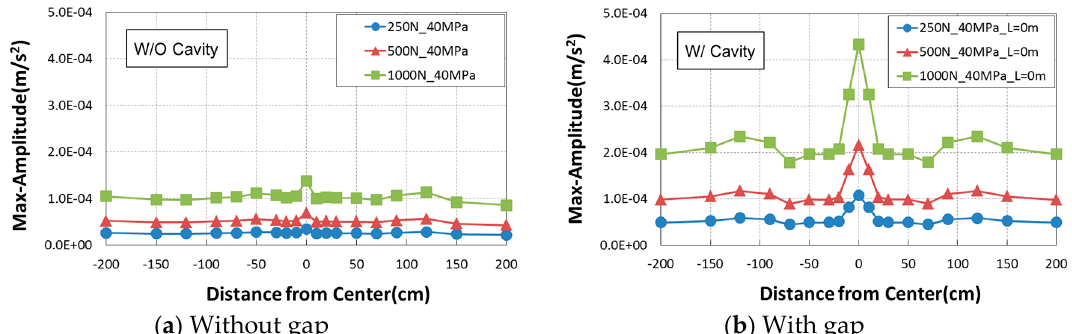
Figure 7. Comparison of maximum acceleration in the air above the concrete surface in cases of with and without cavities at different position from impact loading point. ( a ) Without gap. ( b ) With gap.